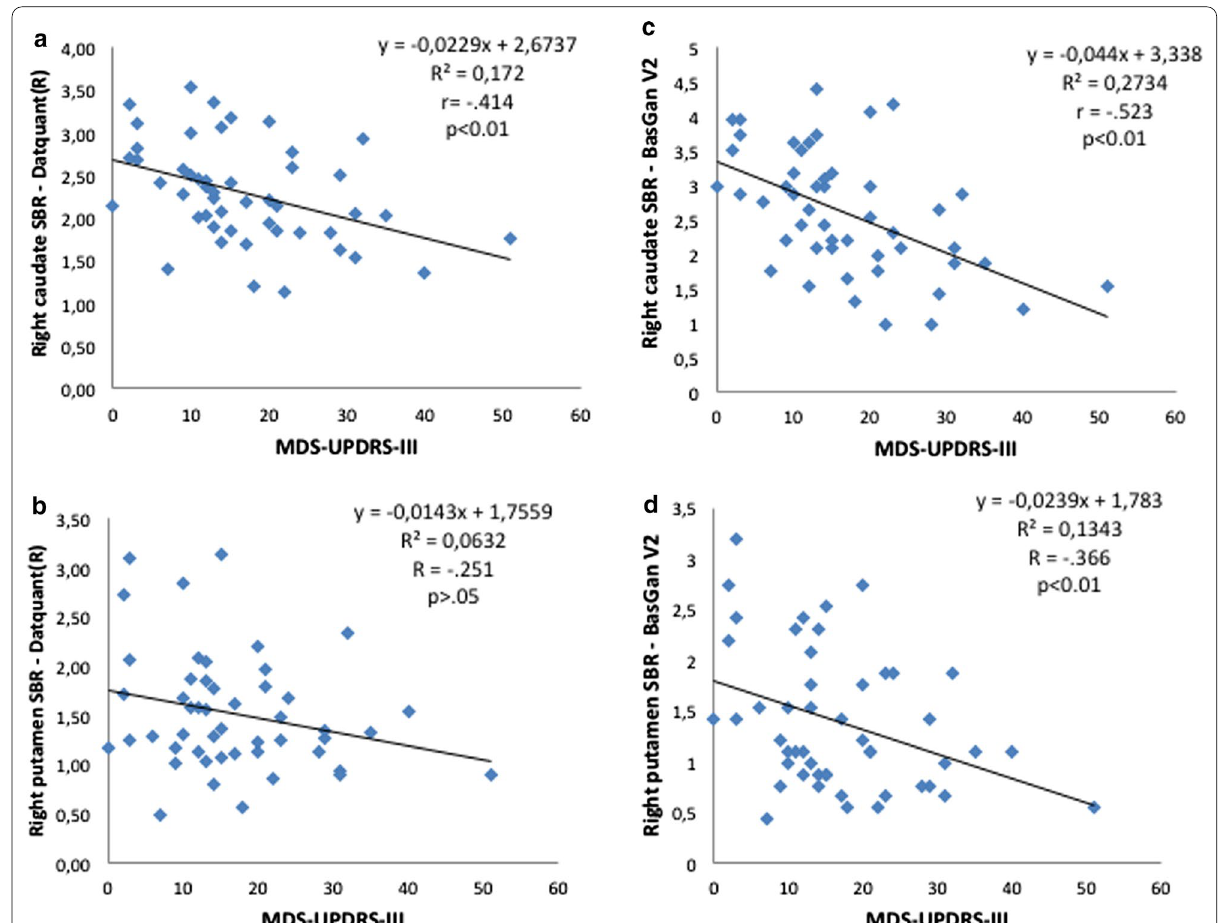
Fig. 2 Plot of linear correlation between MDS-UPDRS-III score ( x -axis) and the SBR of the caudate and putamen nuclei as achieved with Datquant ® ( a , b ) and BasGanV2 ( c , d ) in 49 patients with parkinsonian syndromes. Intercept equation, R 2 , r , and p values are embedded in the figures